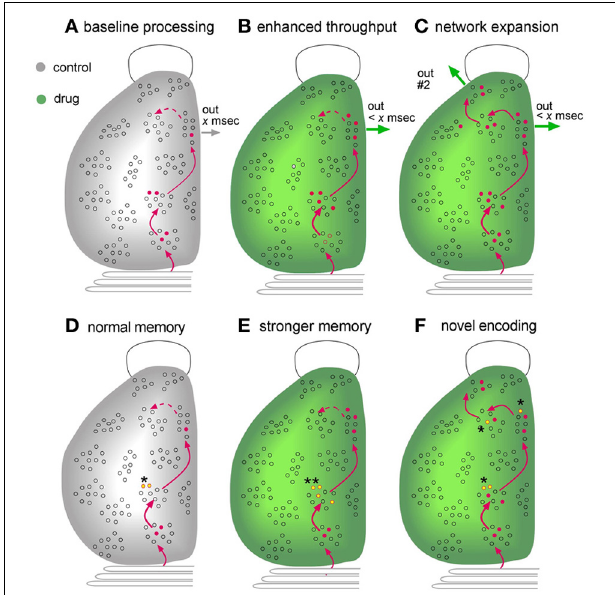
FIGURE 7 | Mapping as an endpoint measure for evaluating the effects of putative enhancers. Schematic illustration of a dorsal view of the left side of a rodent brain, with an open outline of the olfactory bulb at top and the cerebellum at bottom. Gray is for control subjects while green denotes results obtained in the presence of an experimental treatment. (A–C) Network Mapping. The figures describe the distribution of cells activated during learning of a novel environment, as could be determined from maps assembled from serial sections labeled for activation of Immediate-Early Genes (see text). Combining this information with neuroanatomy (red lines) would provide a picture of the extent to which known circuits were engaged during learning. (A) Interaction with the environment increases the number of cells firing (red dots) in three successive stages of a transcortical network, resulting in output from the third stage. A fourth region that that is weakly innervated by preceding network stages (dotted line) is not engaged. (B) A compound that facilitates excitatory synaptic transmission increases the number of neurons that respond to the input and thereby reduces circuit-throughput time ( < x ms) and generates a more robust network output. (C) An additional possibility, supported by experimental work, is that improved transmission adds regions to the network, resulting in novel outputs (“out #2”). Potentially, the cortex in this instance would gain new capabilities for dealing with complex problems. (D–F) Mapping of encoding sites (engrams). Recent advances have made it possible to identify synapses that are modified by recent learning. Mapping studies for hippocampus strongly suggest that such effects are restricted to a small number of sites in a multiple stage network (see text). (D) Under control conditions, memory-related synaptic changes, such as LTP, are restricted to stage #2 (yellow dots, asterisk) of one network engaged during learning. (E) An enhancer could increase the number of neurons on which such synaptic changes occur in regions in which they are normally found (double asterisks). Such an effect is predicted to result in the formation of stronger memory (e.g., more resistant to extinction). (F) Improved transmission relating to an experimental treatment reduces the threshold for inducing memory-related synaptic alterations such as LTP. It follows from this that the manipulation could result in synaptic modifications in regions at which they do not normally occur (multiple asterisks). This is predicted to produce an elaborated, novel representation of the learned